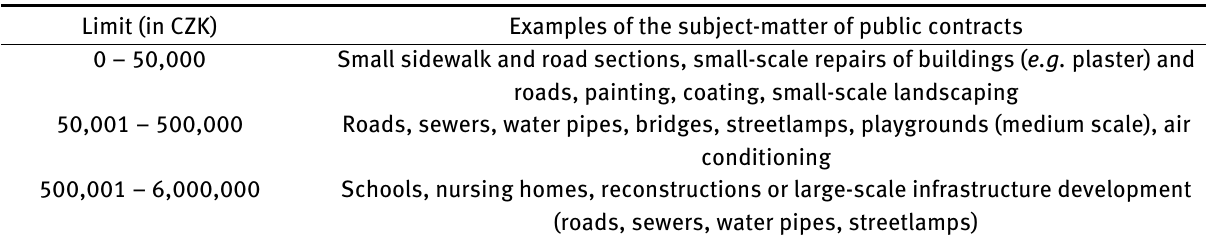
Table 3: Typical examples of small-scale public contracts according to financial categories. Limit (in CZK)